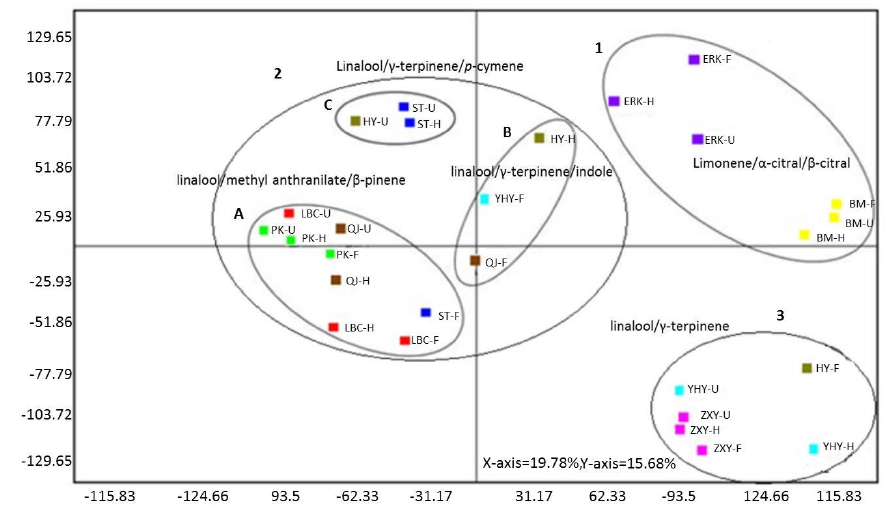
Figure 4. Principle component analysis (PCA) of flower volatiles from nine citrus cultivars during blooming (abbreviated names of cultivars are presented in Table 1; each color represents one cultivar; while U, H and F represents unopened, half opened and fully opened flower stages). Note: each subgroup exhibited abundant